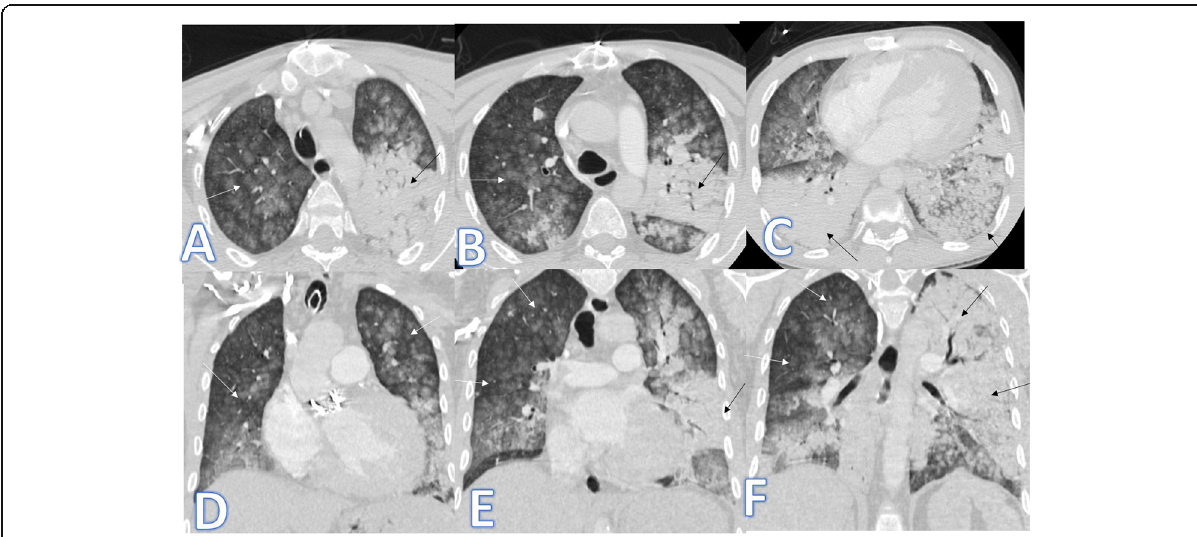
Fig. 19 A 32-year-old male patient with ESRD on dialysis presented with fever and cough. CT showed bilateral high-density ground glass centrilobular nodules (white arrows) due to metastatic pulmonary calcification occurring in renal failure. Associated left lung consolidative patches with air bronchogram (black arrows). The diagnosis was metastatic calcification with superadded lung